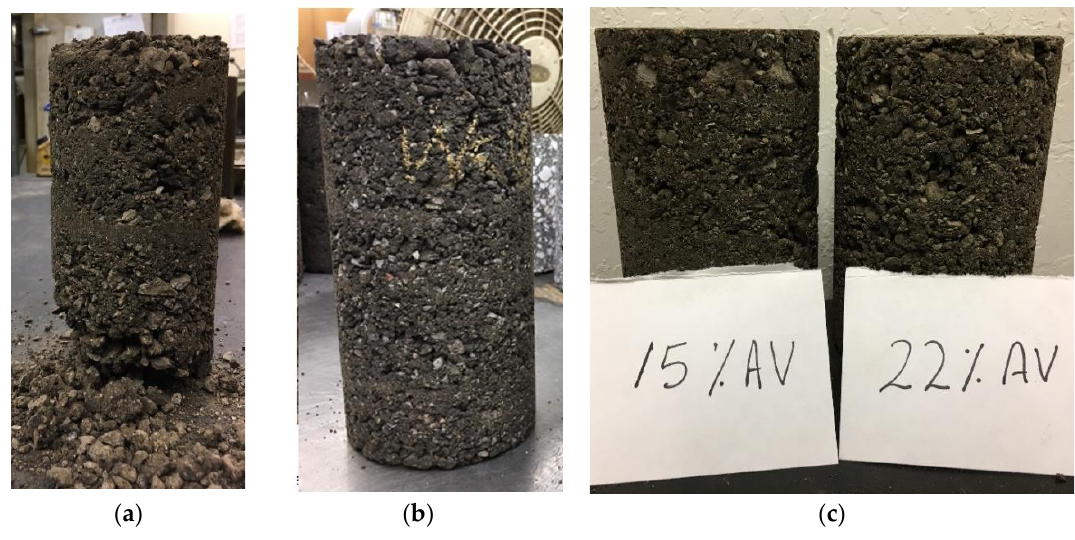
Figure 8. RAP milling resilient modulus test specimens before ( a ) and after ( b , c ) modification to AASHTO T-307 sample preparation. Table 5. Regression coefficients of Universal model for RAP